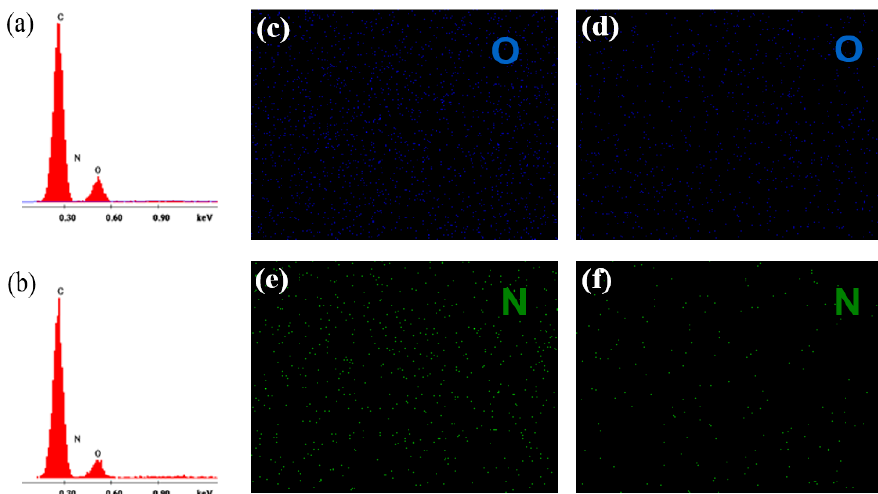
Figure 5. The EDS spectra and mapping images of the PUA latex films (37 wt.% Endo-L-Borneol